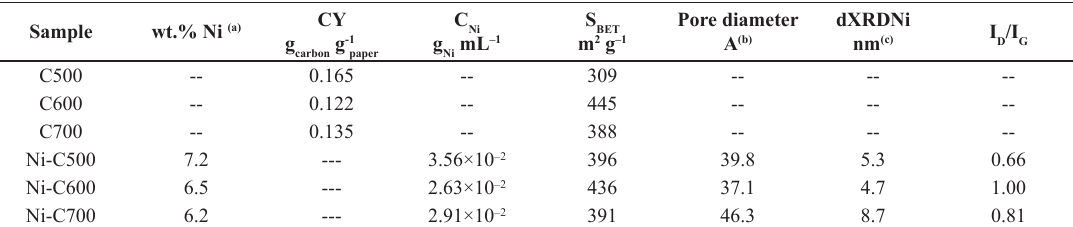
Table 1. Some properties of Ni-C samples.